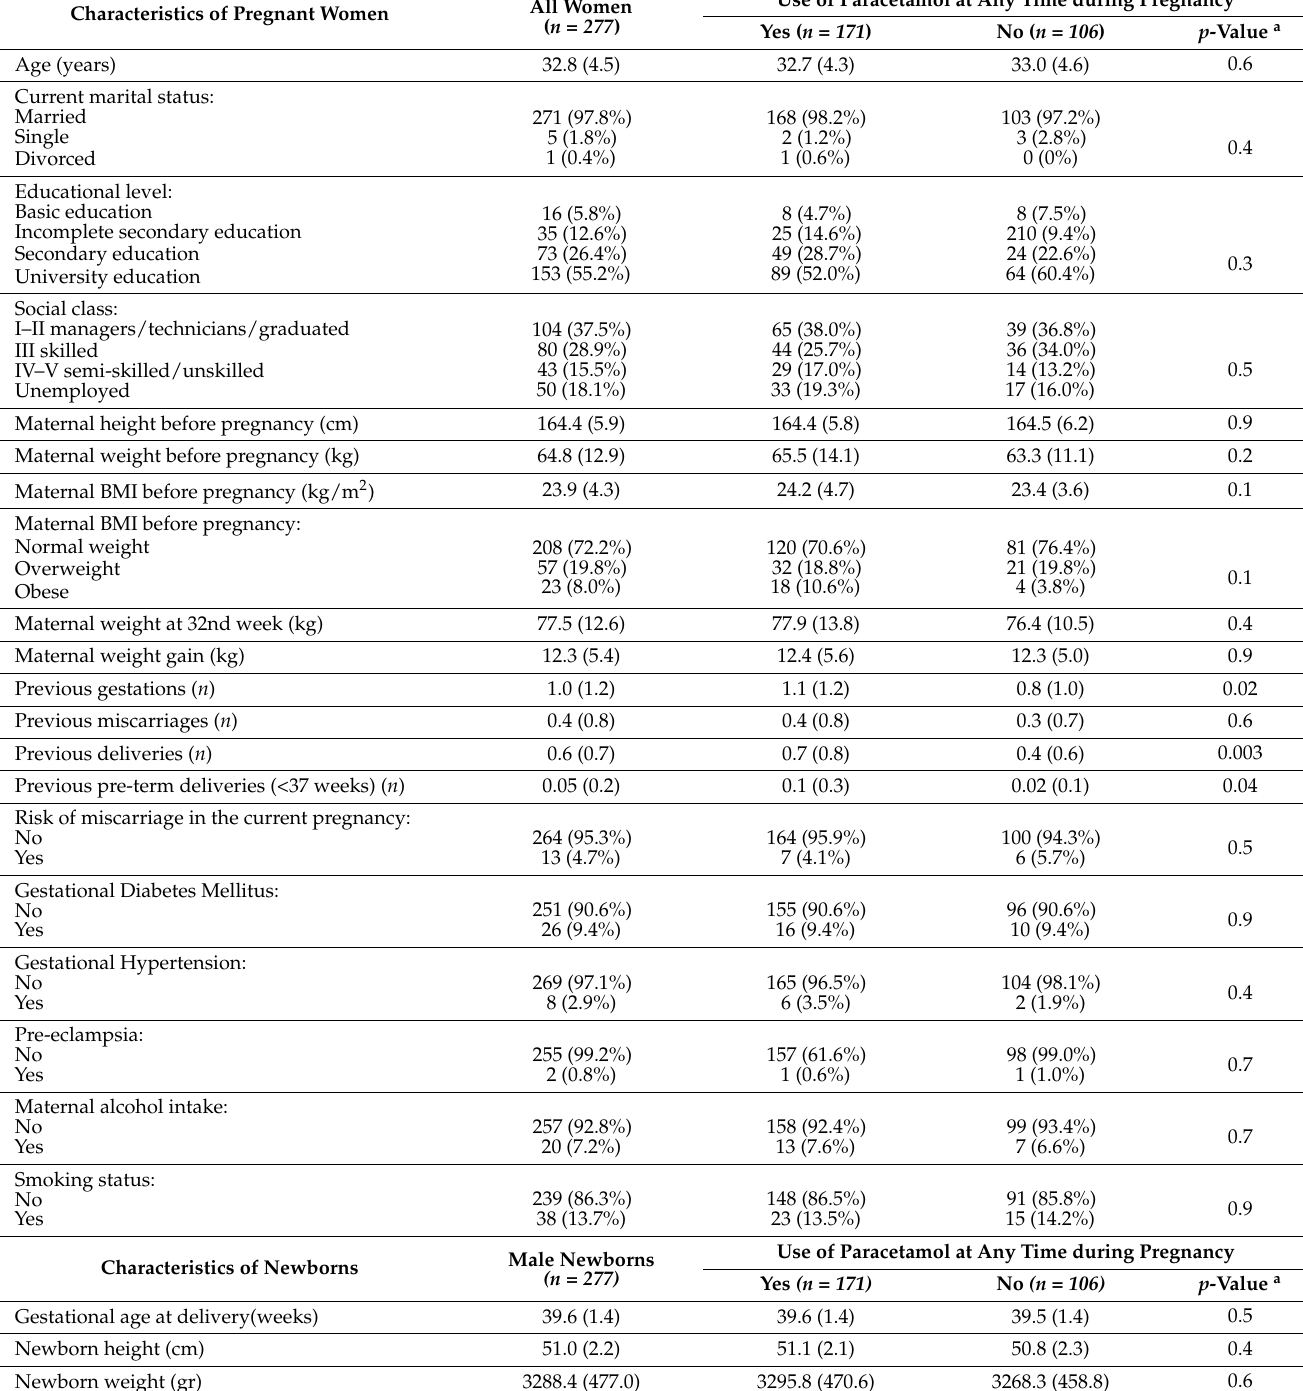
Table 1. Characteristics of participants in the current study (mean and standard deviation (SD) or n (%)). p -value ≤ 0.05 is considered statistically